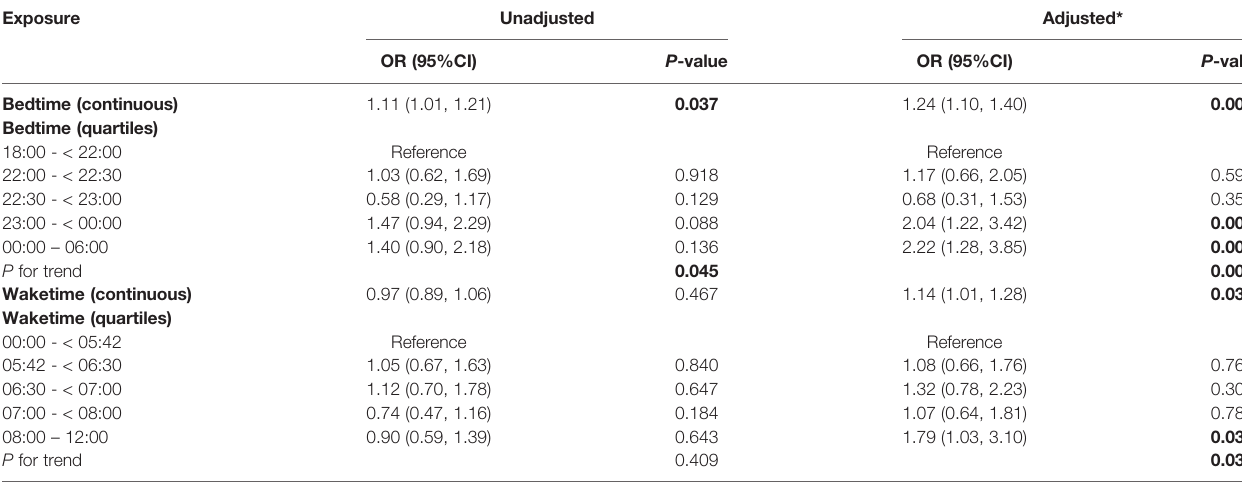
TABLE 2 | Relationship between sleep behaviors (bedtime and waketime) and infertility in unweighted sample. Exposure